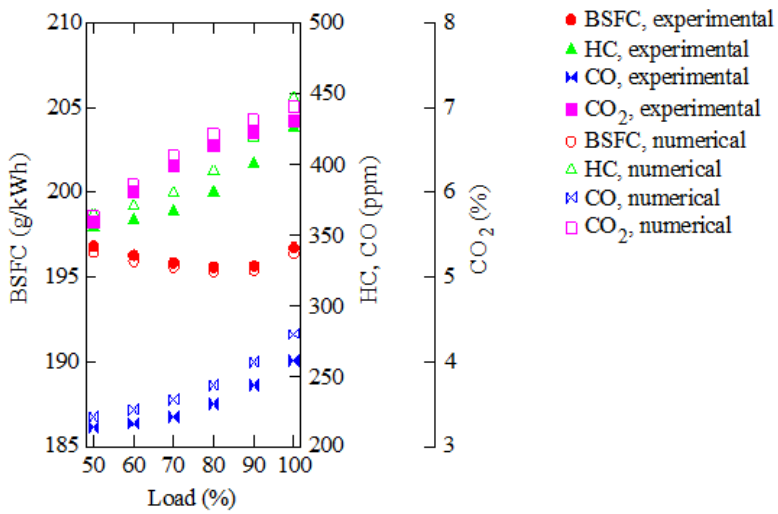
Figure 5. HC, CO, and CO 2 emissions as well as brake-specific fuel consumption (BSFC) experimentally and numerically obtained.